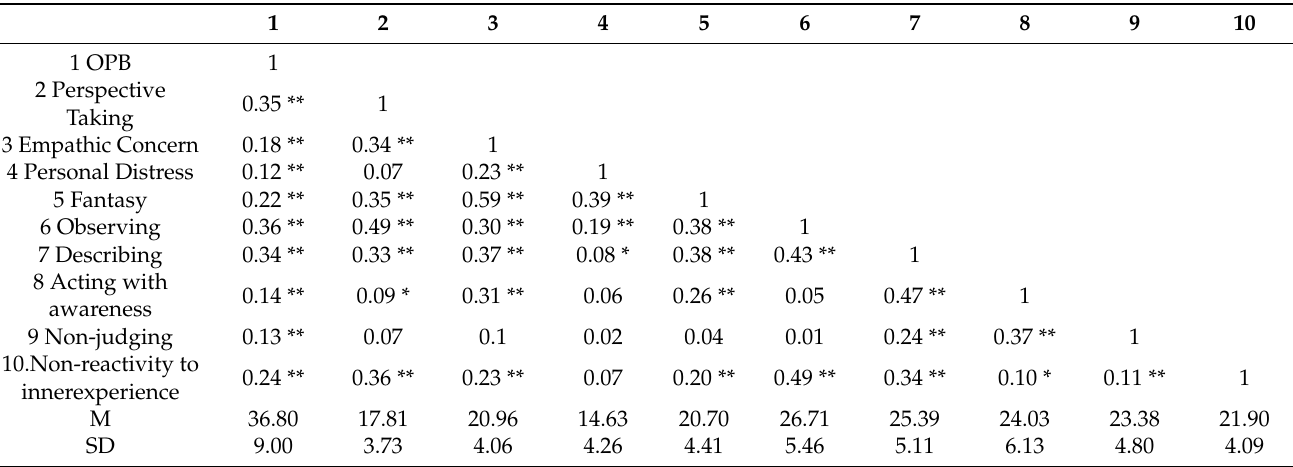
Table 1. Means, standard deviations, and Pearson correlations among research variables ( n = 674).